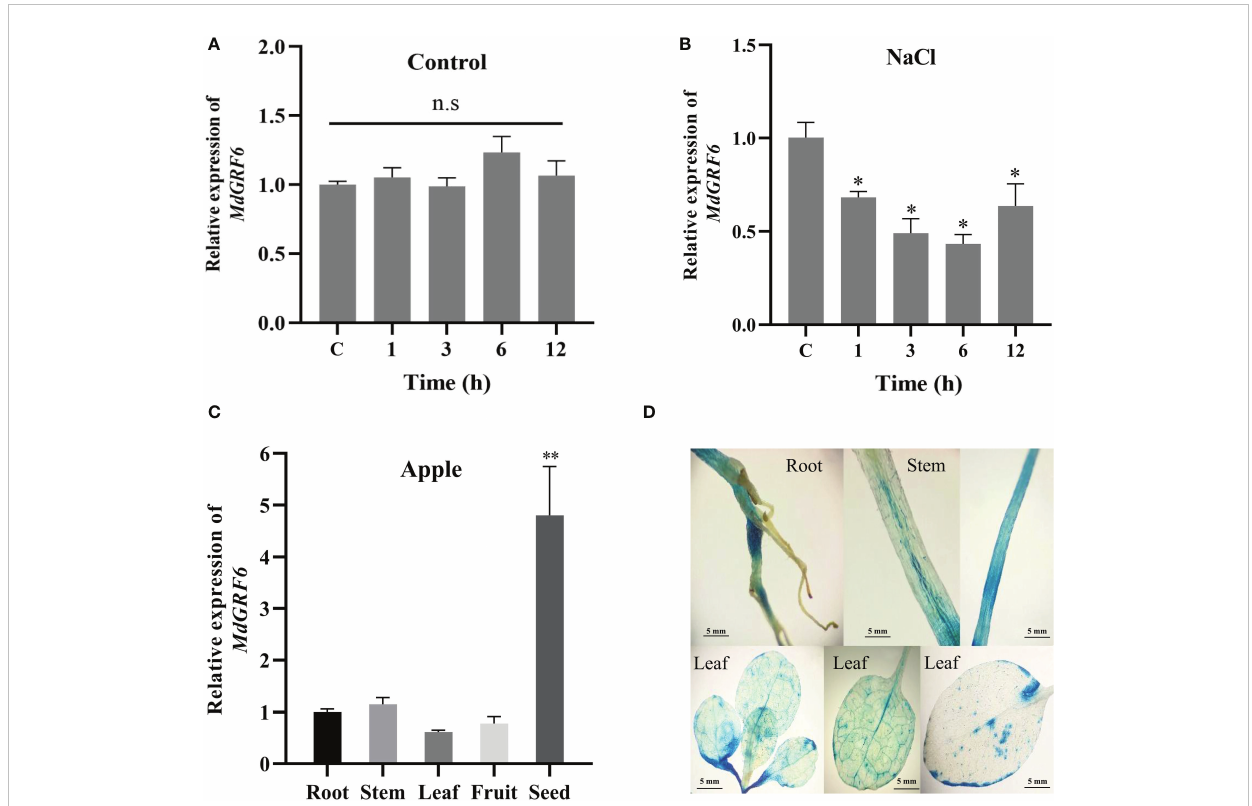
FIGURE 4 Expression patterns of Md14-3-3 genes. (A, B) RT-qPCR analysis of MdGRF6 expression in apple seedlings treated without or with 100 mM NaCl for the indicated time. (C) Expression analysis of MdGRF6 in different apple tissues. (D) P MdGRF6 ::GUS expression pattern in transgenic tobacco in different tissues. Data are presented as means ± SD (n = 3). Asterisks indicate signi fi cant differences LSD test, ** P < 0.01; * P < 0.05; ns, no signi fi cant